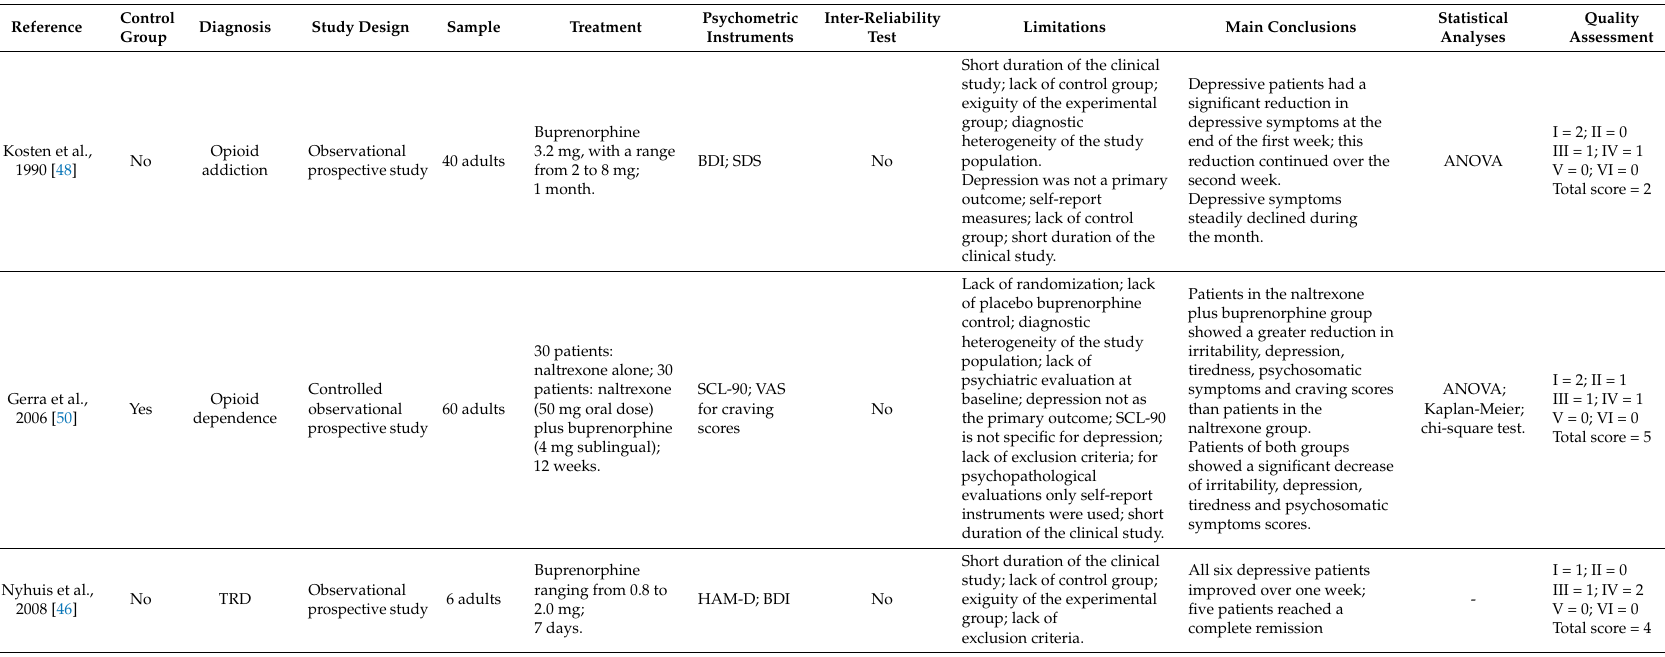
Table 2. Summary of the most relevant prospective studies concerning BUP and depression/suicidal behavior included in the present